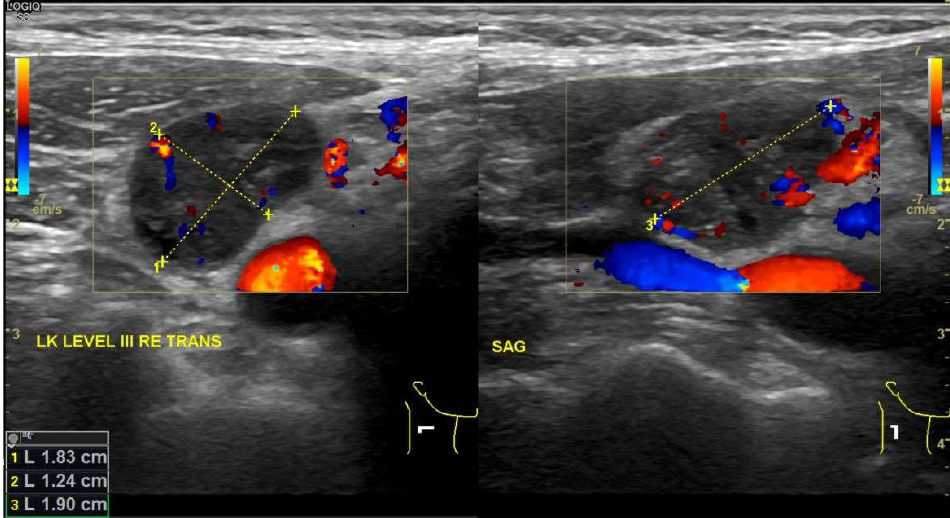
Figure 4. Ultrasound images of right transverse lymph node level III. Lymph node demonstrates malignant characteristics: axes are larger than 1 cm (left image), round shape with necrotic areas (right image).